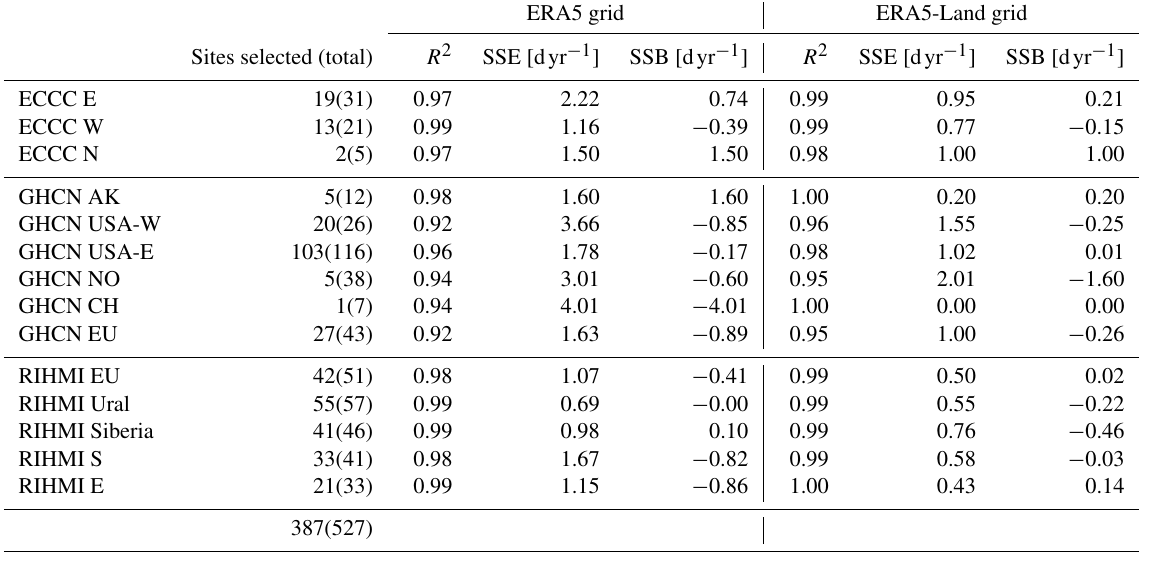
Table 2. Spatial representativeness metrics ( R 2 , SSE – spatial sampling error, SSB – spatial sampling bias) per region in the group of stations selected for the validation after discarding low spatially representative sites.